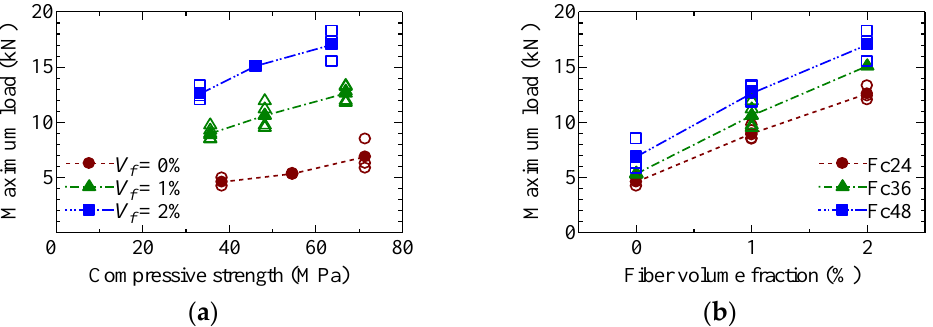
Figure 8. Relationship between maximum load and experimental parameters: ( a ) compressive strength; ( b ) fiber volume fraction.